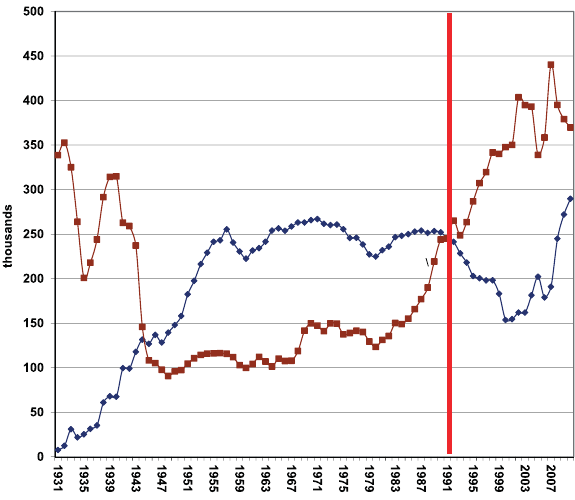
Fig. 7. A comparison of domesticated reindeer populations in different forms of ownership in the Iamal-Nenets okrug; Enterprises ( ―♦ ), Households ( ―■ ). From the 1930s to the end of WWII, the population of reindeer in enterprises increased while the population of family households fell due to collectivization. Indeed, herders owned up to 50% of the total reindeer stock in the Soviet period. Since the 1980s, the number of reindeer in households increased to around 400 000 head in the 2000s while during the crisis from 1991, the number of reindeer in enterprises declined considerably from 250 000 to 150 000 animals but is on its way up from 2000 due to support of regional authorities. In recent years, some family households joined together into small-scale clan-communities which are officially classified as reindeer enterprises. This explains why the population of reindeer in households